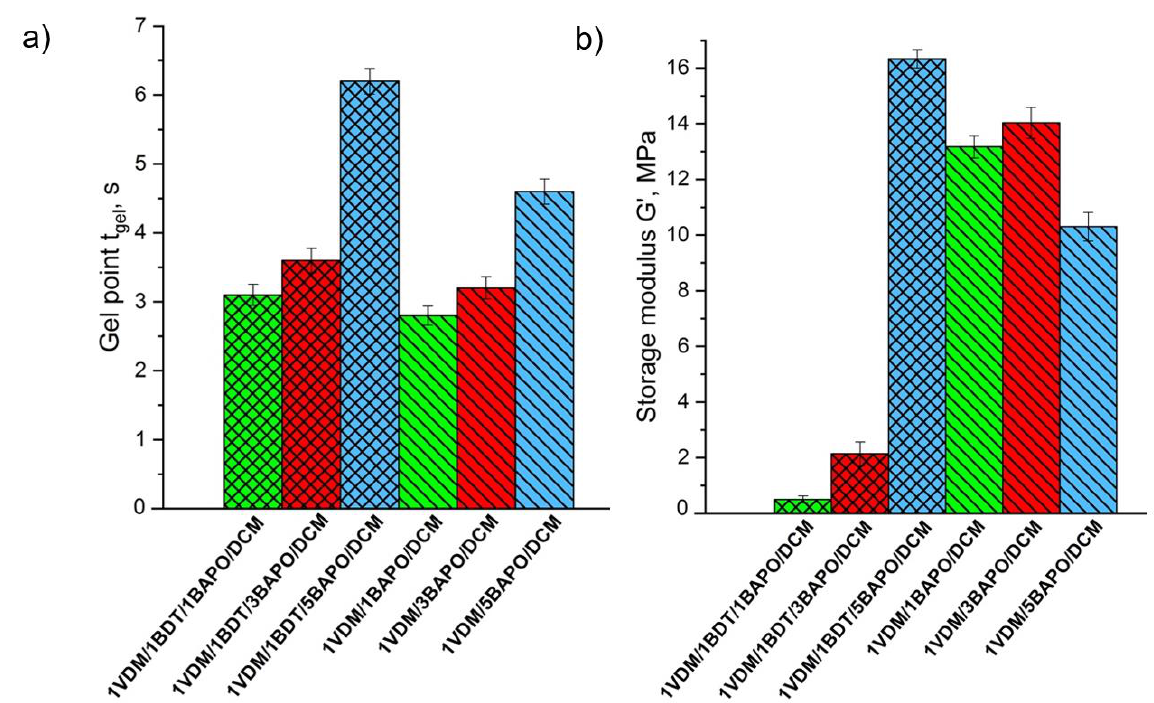
Figure 2. Gel point t gel ( a ) and storage modulus G ’ ( b ) of the VDM-based resins. Green columns—1 mol% of BAPO; red columns—3 mol% of BAPO; blue columns—5 mol% of BAPO; leaning lines from bottom to top—presence of 1,3-benzenedithiol (BDT); leaning lines from top to bottom—presence of dichloromethane (DCM).